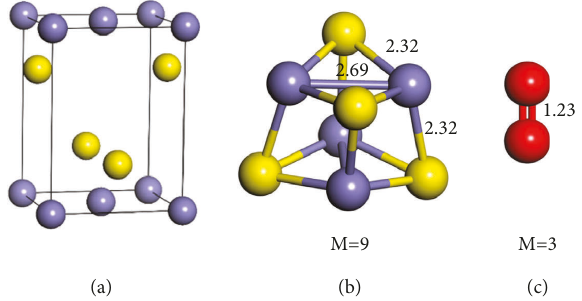
Figure 2: (a) FeS crystal model. (b) Fe 4 S 4 cluster model. (c) O 2 structure model. (Purple represents Fe atoms, yellow represents S atoms, and red represents O atoms). M represents spin multiplicity; bond length unit: